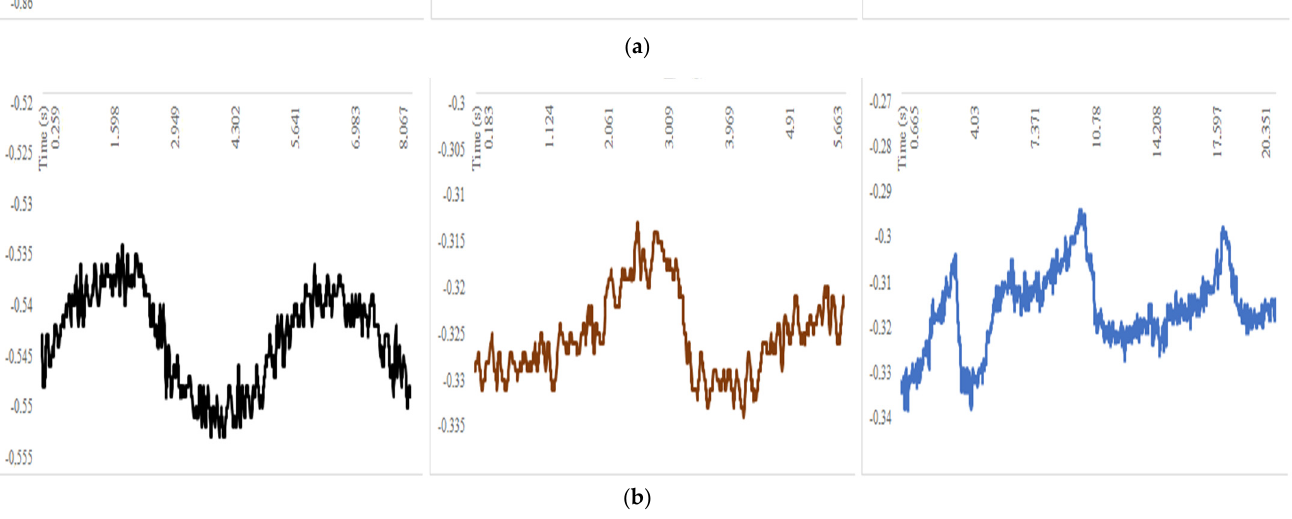
Figure 6. Acquired data by SENSIRIB on the sixth rib on a volunteer for a test in terms of: ( a ) roll angle; ( b ) pitch angle (in black for the pre-operative condition, in red for the post-operative condi- tion on the operated side, in blue for the post-operative condition on the non-operated side).